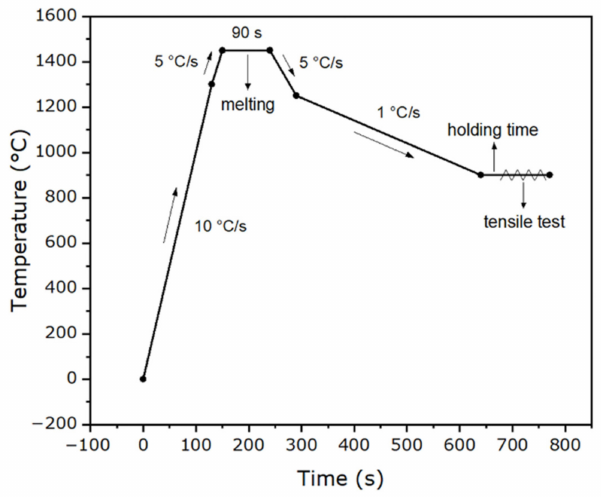
Figure 3. Experimental thermal